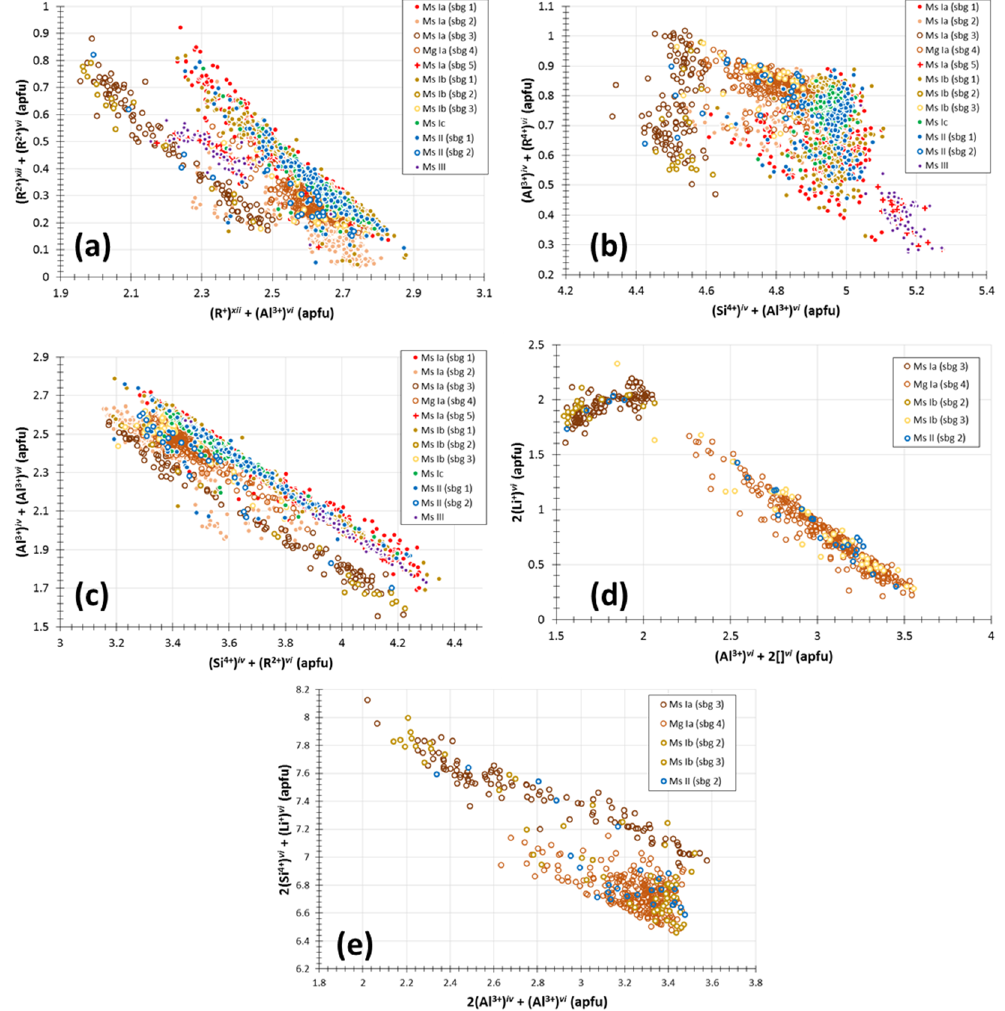
Figure 9. Cross-plots of atoms per formula unit (apfu) in different coordination sites documenting the prevailing substitution mechanisms in the analyzed mica groups and subgroups, as indicated in text for each case, from ( a – e ).